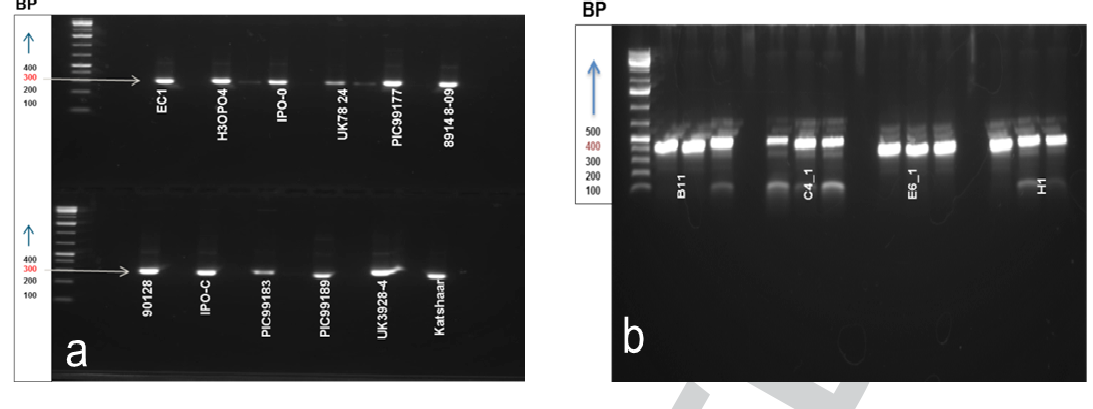
Figure 1. Amplified Scr74 gene of Phytophthora infestans isolates (a) and three positive clones of the four novel Scr74 variants in the vector PGWC-PVX (b)